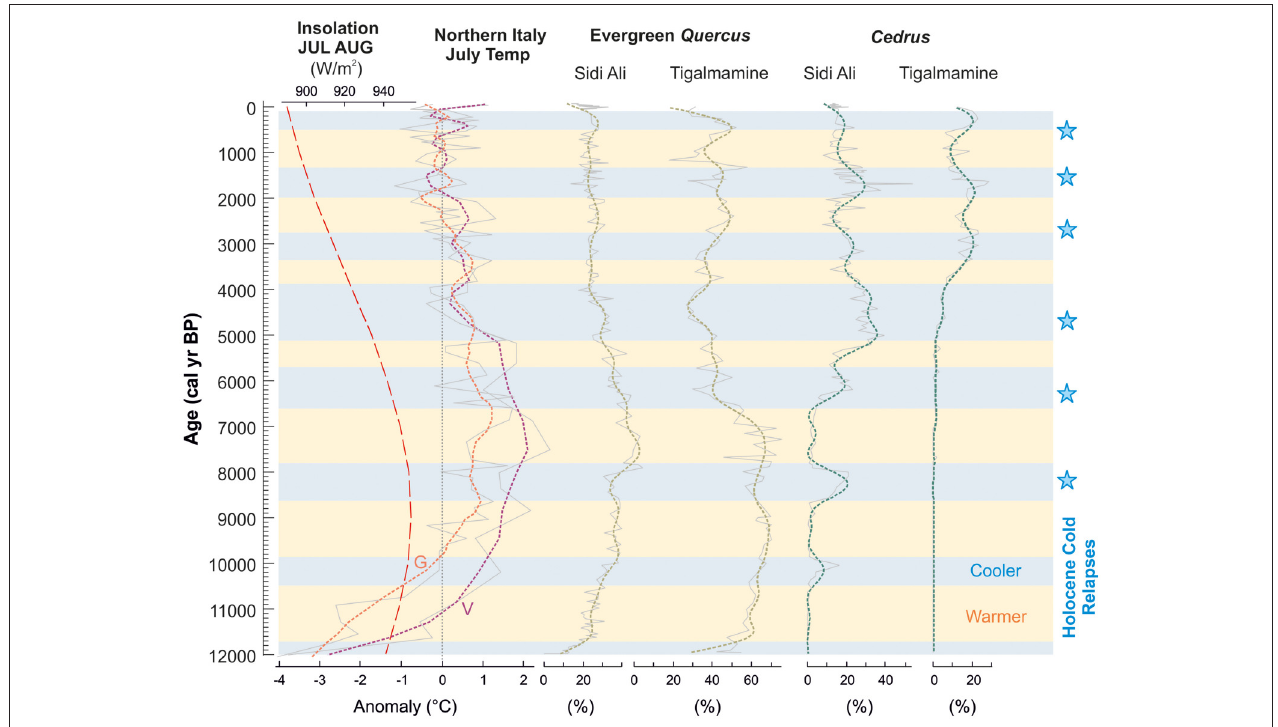
FIGURE 11 | Inferred summer temperature variability in the Middle Atlas, Morocco, showing: orbital insolation parameter for combined July and August insolation at 30 ◦ N (Berger and Loutre, 1991); chironomid-based summer temperature reconstructions from Gemini (G) and Verdarolo (V) in northern Italy (Samartin et al., 2017); pollen curves for warm-tolerant (evergreen Quercus ) and cool-tolerant ( Cedrus ) trees at Lakes Lake Sidi Ali (this study) and Tigalmamine ( Lamb and van der Kaars, 1995 ). Dashed lines through the pollen curves show results of lowpass filter (1,000 year) removing centennial variability. Stars indicate global Holocene “cold relapses” (Wanner et al.,